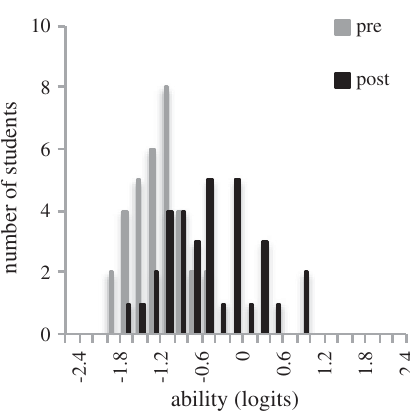
FIG. 38. The pre- and postability histogram for class